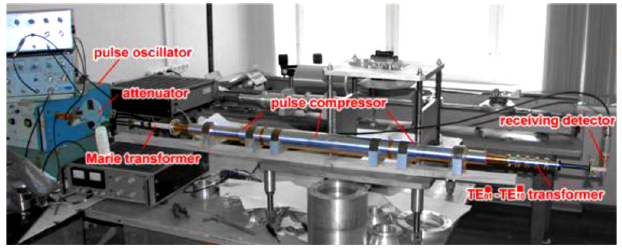
FIG. 14. (Color) Photograph of the 30 GHz prototype.